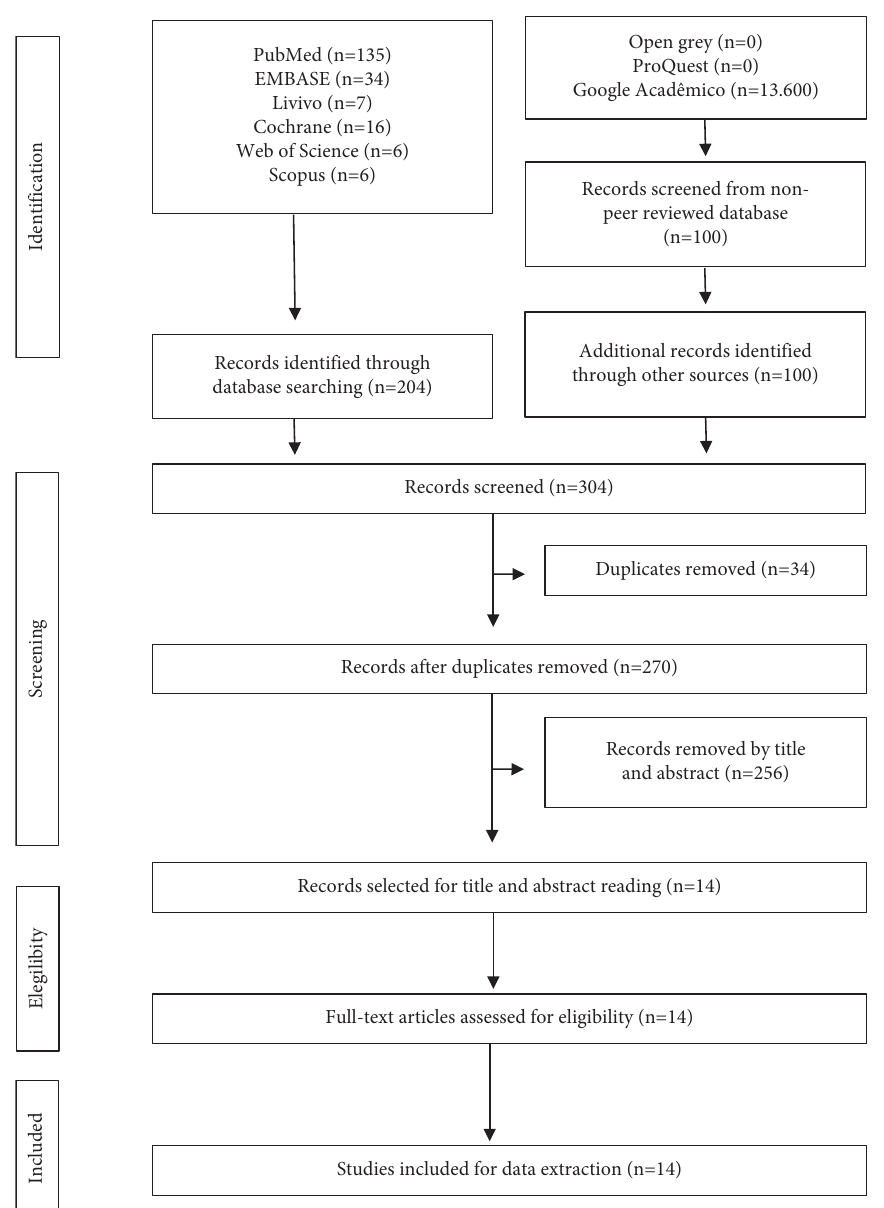
Figure 1: Description of included records in the scoping